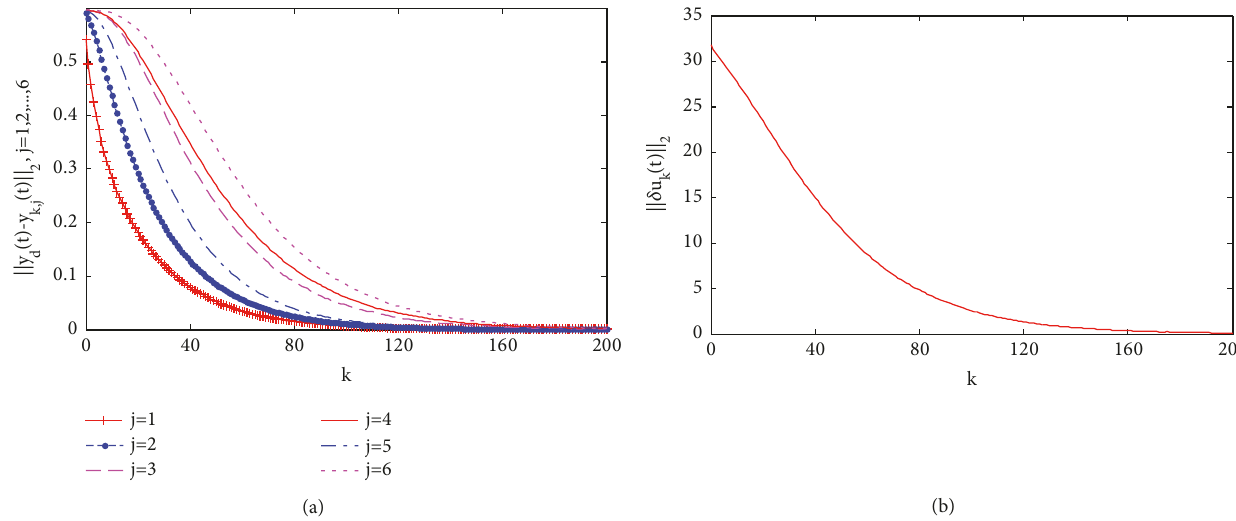
Figure 5: Under the observer (6) and the controller (11) with 𝐾 = [0.3113,0.2105] and Γ = [−0.0032,0.0549] : (a) output tracking errors versus iteration numbers; (b) input errors ‖𝛿𝑢 𝑘 (𝑡)‖ 2 versus iteration numbers (color